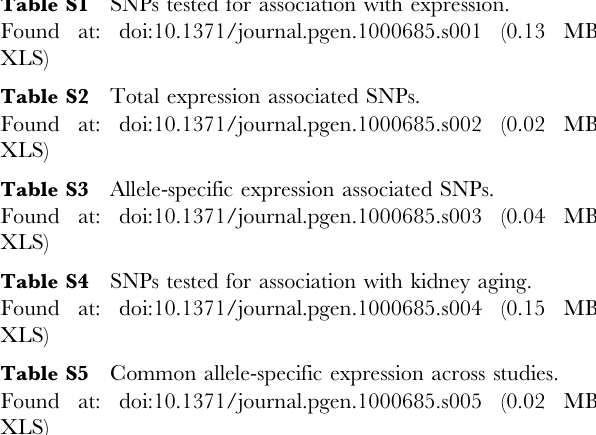
Table S1 SNPs tested for association with expression.